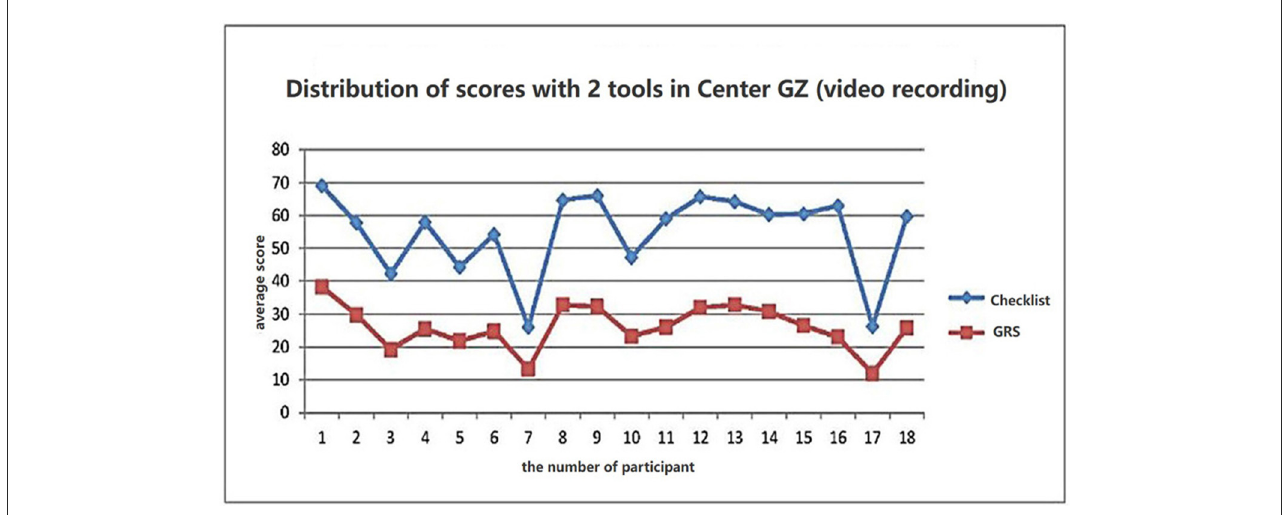
FIGURE1 Mean score distribution of the resident group with GRS and checklist. Score differentiation between the two assessment tools, Pearson’s correlation 0.9.